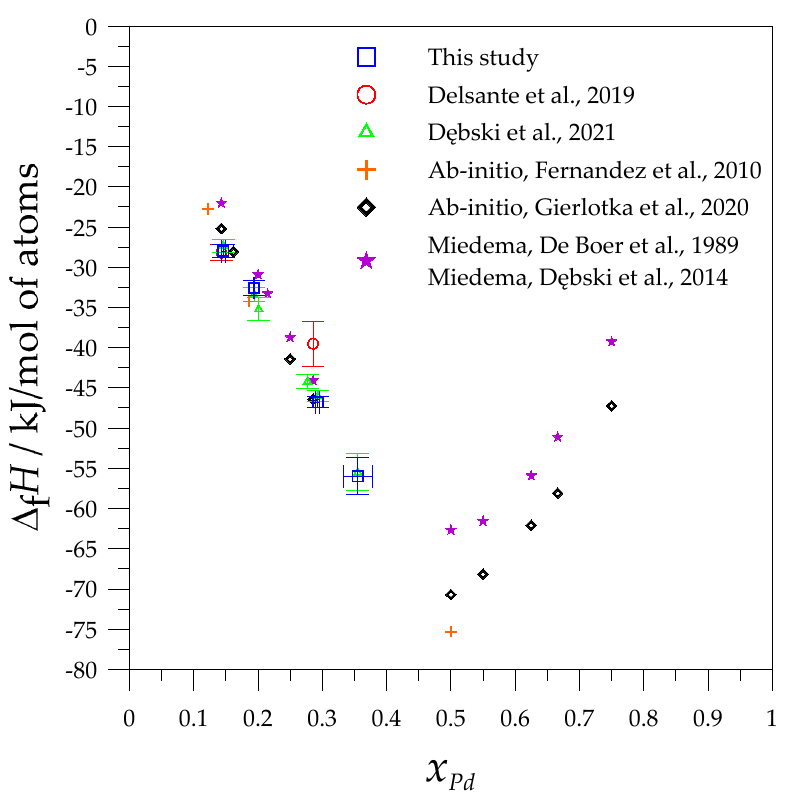
Figure 2. Comparison of the experimental and calculated values of the standard formation enthalpies of the Mg-Pd intermetallic phases and alloys (solution method: in liquid aluminum—this study, in liquid tin (D ę bski et al., 2021 [37]) , direct reaction method (Delsante et al., 2019 [36]) , with ab initio calculations (Fernandez et al., 2010 [34] ; Gierlotka et al., 2020 [38]) and the Miedema model (De Boer et al., 1989 [45] ; D ę bski et al., 2014 [46] ).